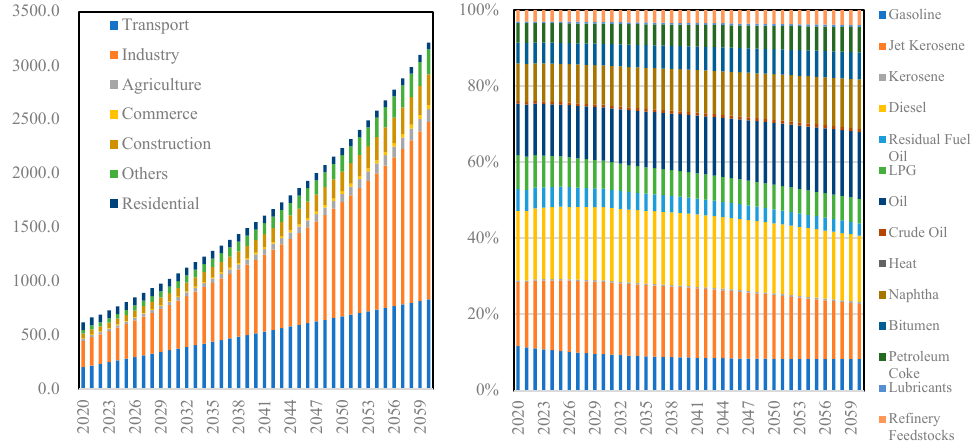
Figure 9. Petroleum products demand by sector ( left ) and fuel type ( right ) in the baseline scenario.